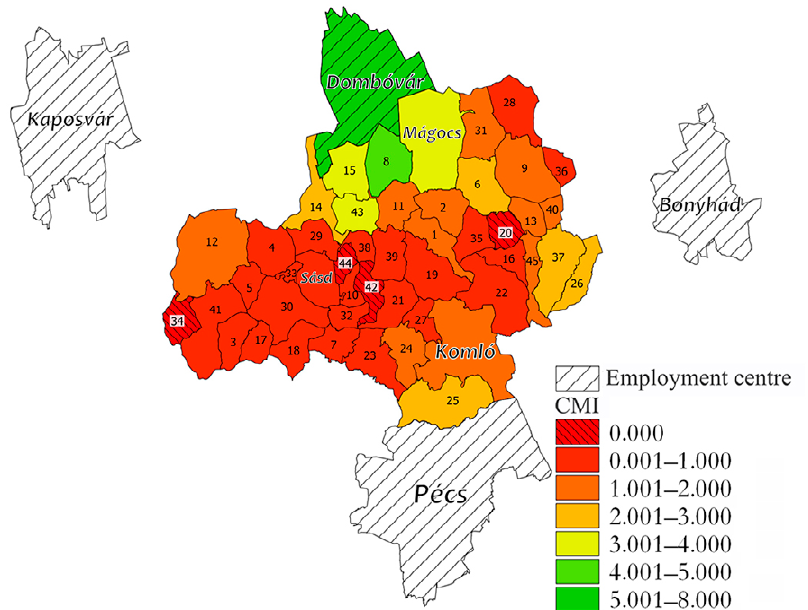
Figure 3. CMI-values of the settlements according to the external